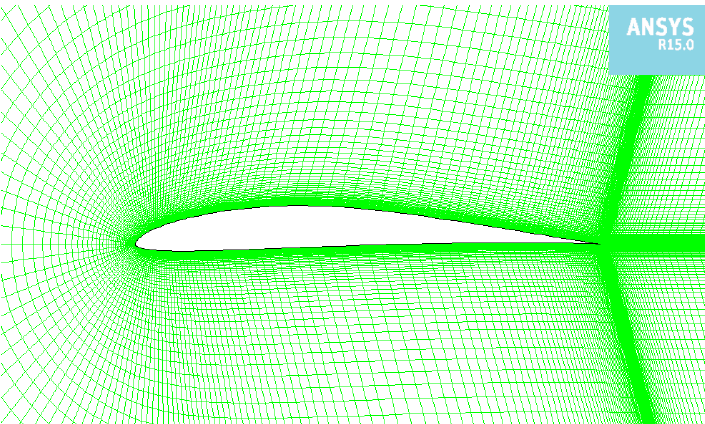
Figure 18. Grids around the E387 airfoil.